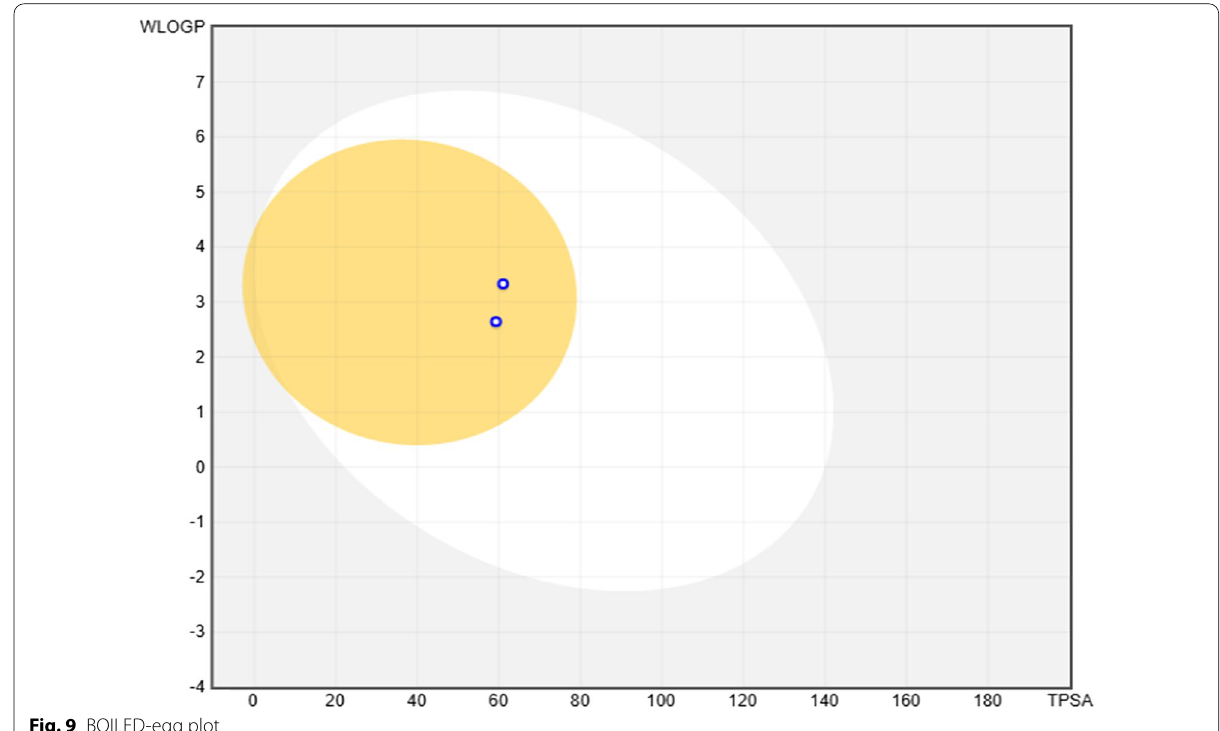
Table 11 lists the physicochemical properties of com- pounds 13 and 21. The compounds passed Lipinski’s rule of five [35]. This further demonstrates the druggability of these